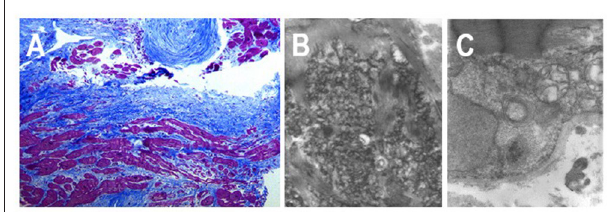
FIGURE 3 | Endomyocardial biopsy from a 18 years-old patient affected by a desmin-related restrictive cardiomyopathy, carrying a pace-maker for complete atrio-ventricular block. (A) Histologic section shows severe interstitial fibrosis and morphological myocytes’ abnormalities with cellular hypertrophy and cytoplasmic vacuolization. (B,C) Transmission electron micrographs show multiple deposits of granulofilamentous material in the intermyofibrillar